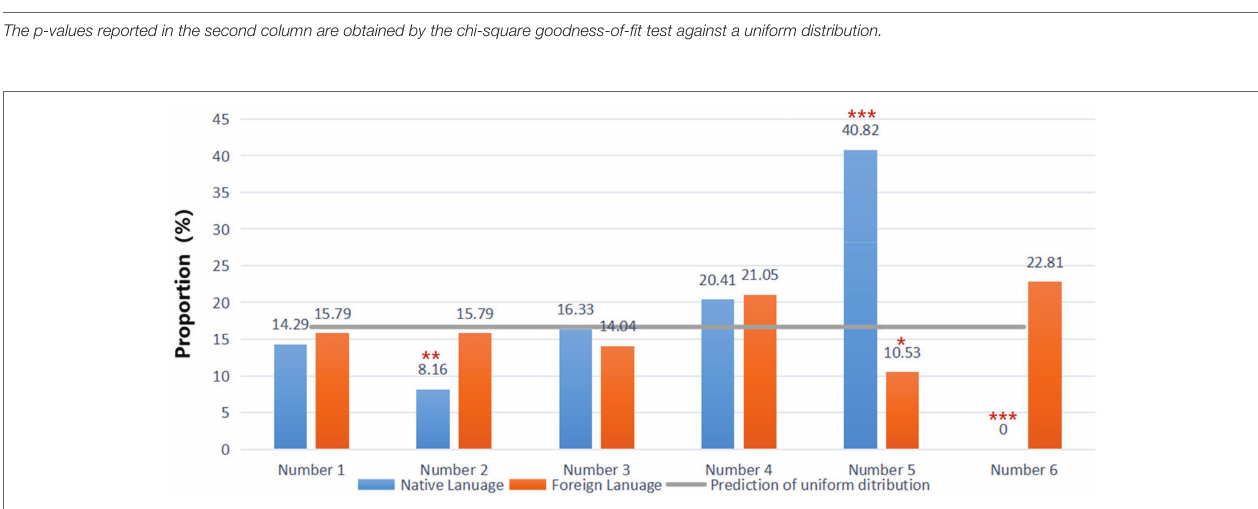
honest people in the FL is much higher than in the